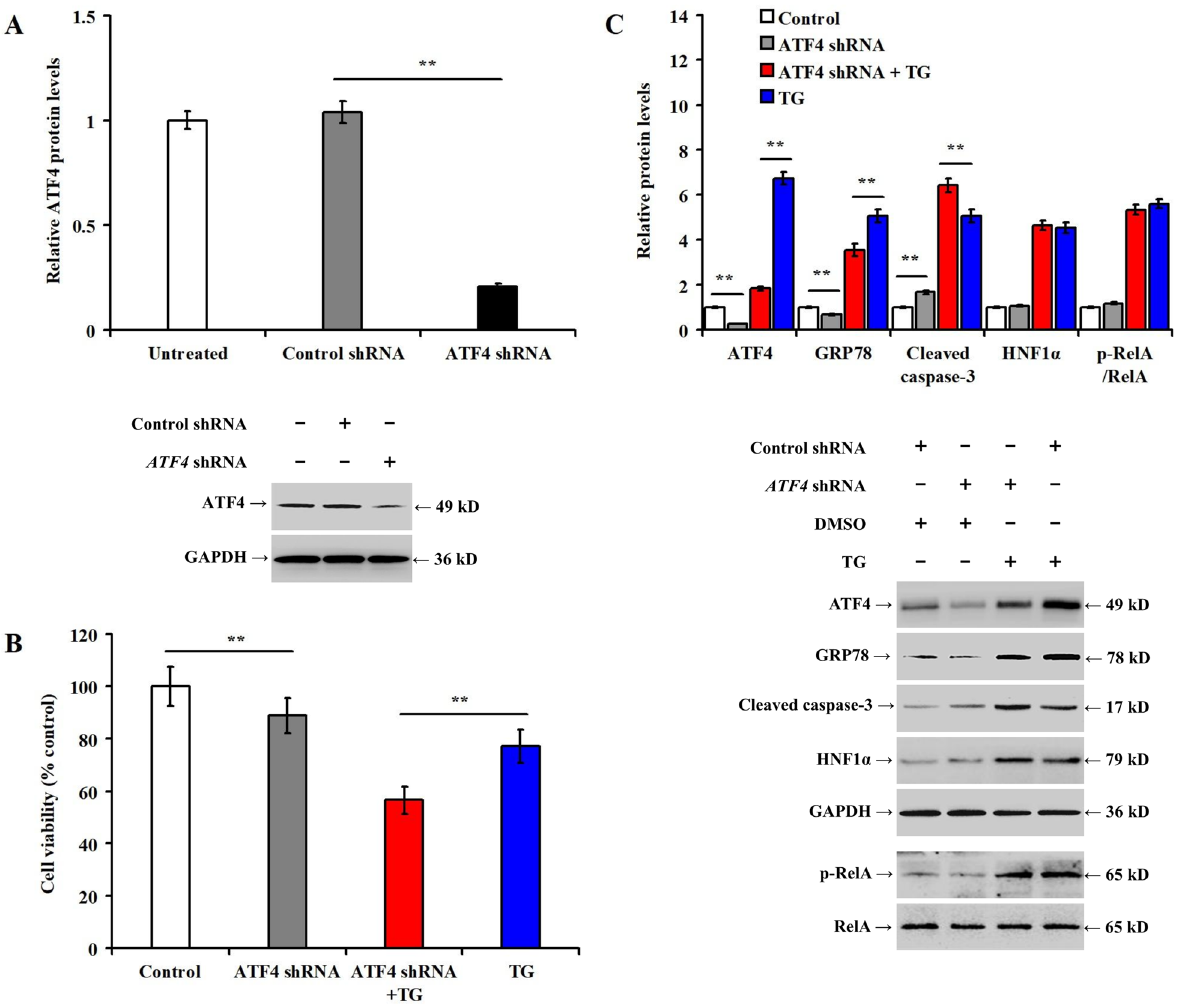
Figure 3. Knockdown of ATF4 aggravates apoptosis and downregulates the expression of GRP78 in TG-treated LO2 cells. LO2 cells were pretreated with control shRNA or ATF4 shRNA for 48 h and then incubated with DMSO or TG (1.0 μmol/L) for 36 h: ( A ) bar chart and representative Western blotting showing the alteration of ATF4 expression in different experimental; ( B ) bar chart representing LO2 cell viability between the different experimental groups; and ( C ) bar chart representing the relative protein expression and representative western blotting.** p < 0.01, versus the control (control shRNA, or control shRNA + DMSO) or TG groups (control shRNA +